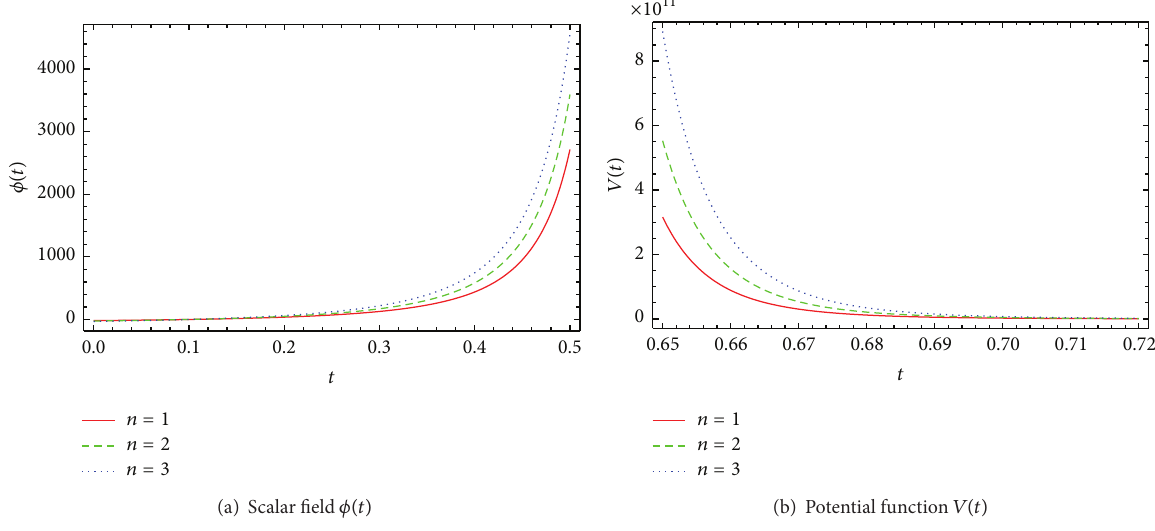
Figure 2: Plots of 𝑓(𝑅,∇𝑅) quintessence scalar field model: (a) scalar field 𝜙 and (b) potential 𝑉 versus cosmic time 𝑡 .